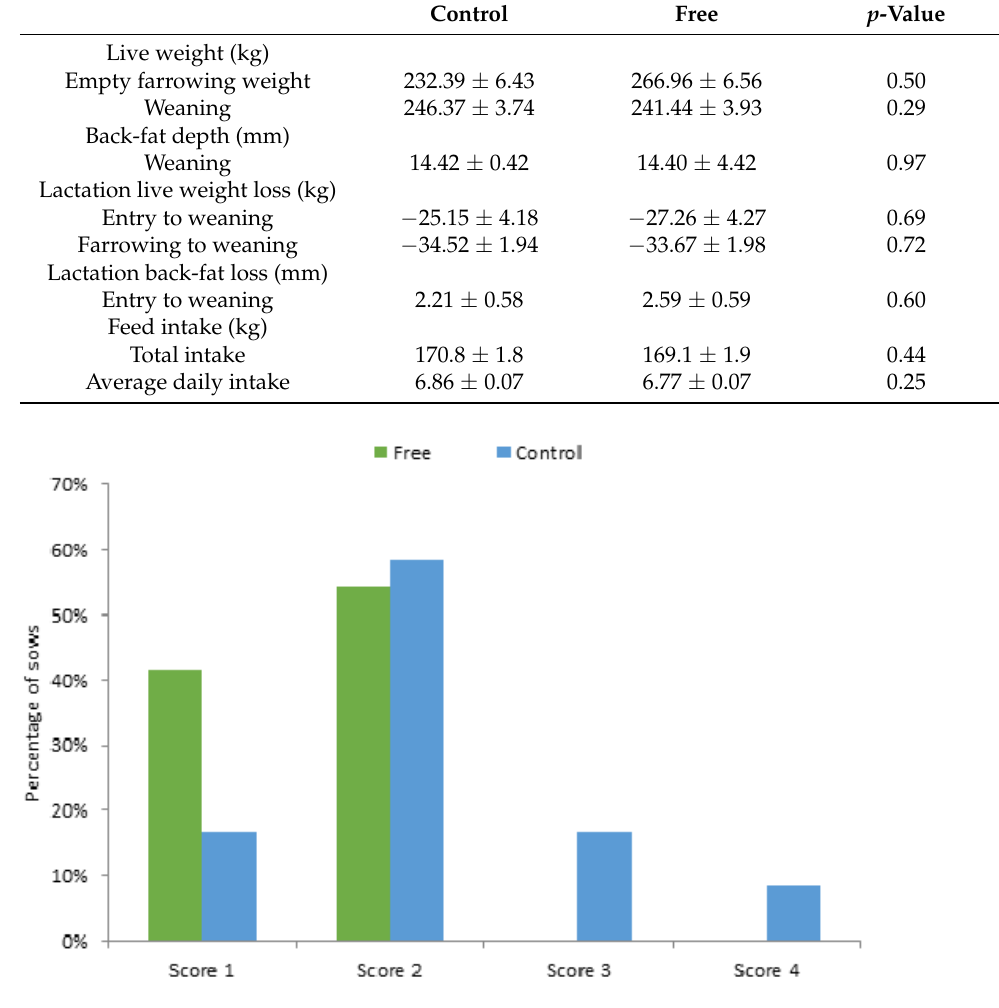
Figure 2. The percentage of sows that had locomotion scores 1, 2, 3 and 4 at weaning. No sows housed in the free lactation treatment had a score higher than 2 at weaning, while 17% of crated sows scored 3, and 8% scored 4 at weaning.